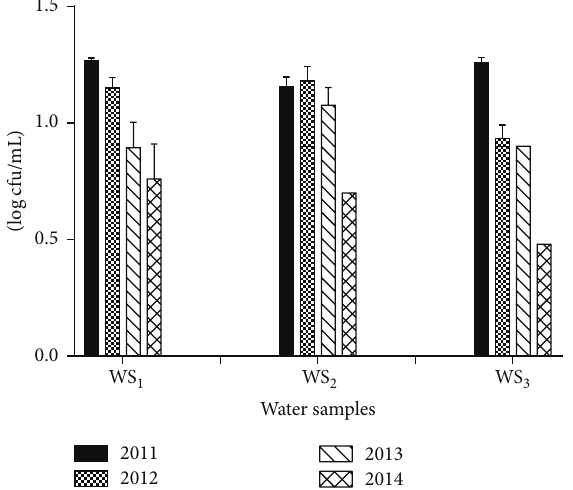
Figure 4: Total viable aerobic count (log cfu/mL) of water samples. The data were representatives of the three independent experiments using triplicate samples and mean ± SD values were